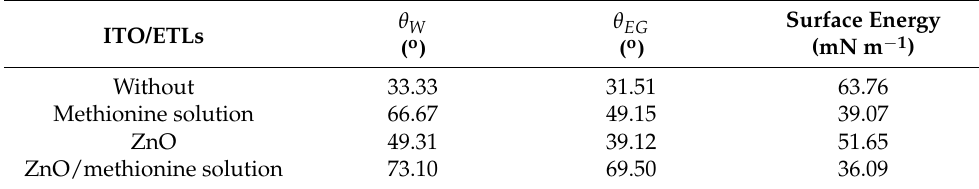
Figure 4. Contact angle images of ITO/ETLs with deionized water or ethylene glycol as the prob- 212 ing liquids. 213 Table 2. Key photovoltaic parameters of OSCs with different ETLs 214